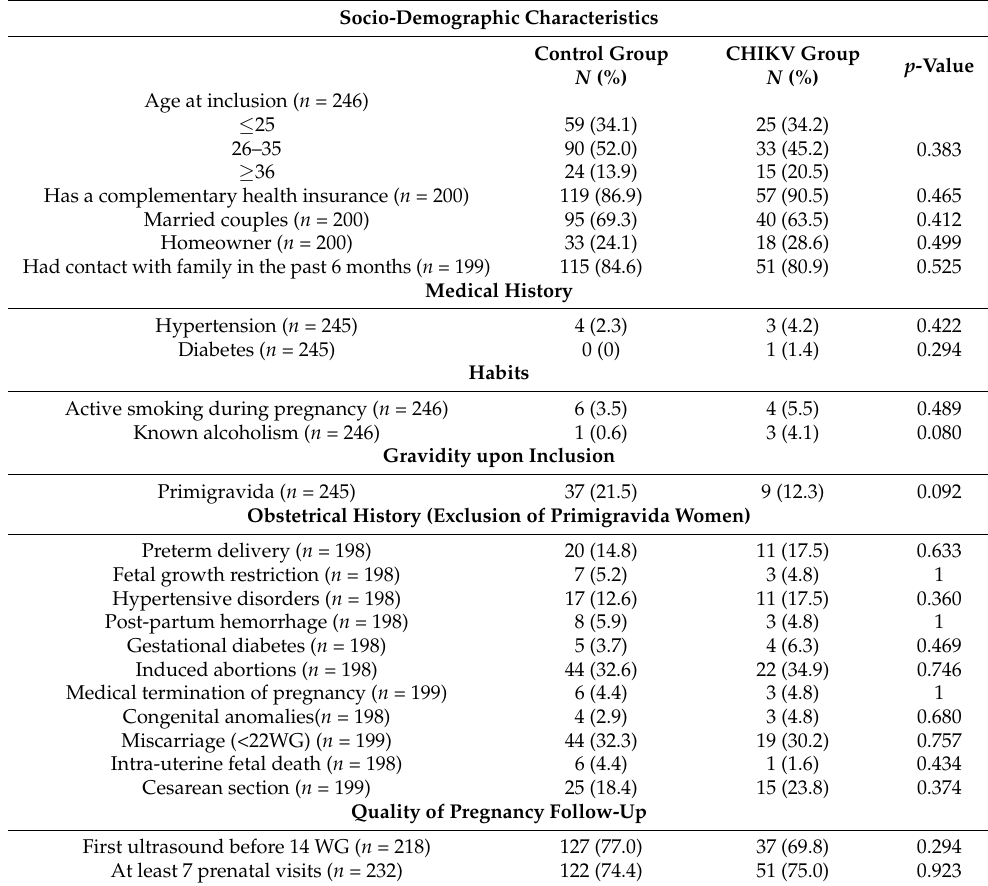
Table 1. Socio-demographic characteristics, obstetrical and medical history, quality of pregnancy follow-up (pregCHIKV study N = 246).